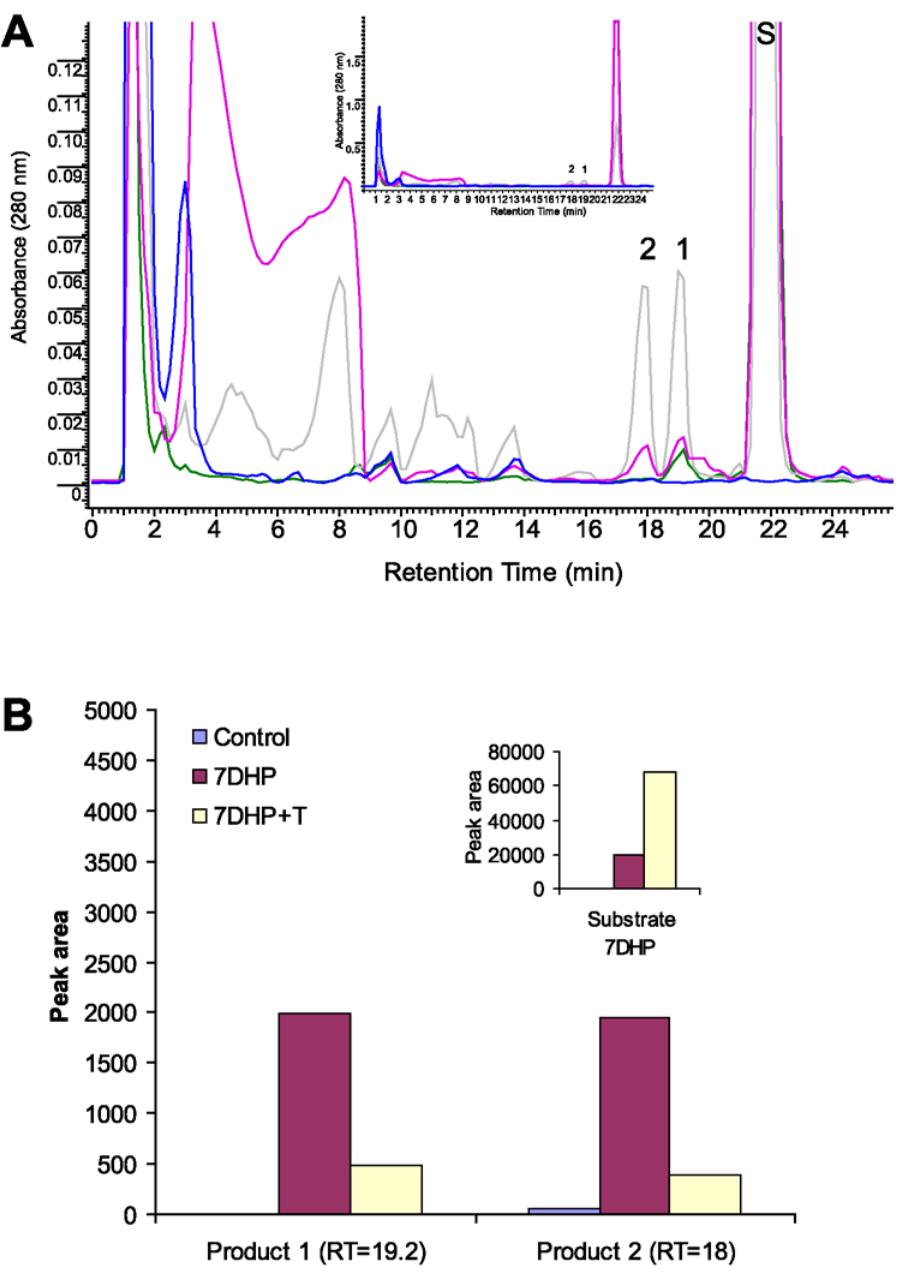
Figure 7. Trilostane (T) inhibits and modifies 7DHP (S) metabolism by rat adrenal glands. A. Fragments of rat adrenal glands were incubated with 7DHP (0.5 mM) in the absence ( pink ) or presence ( gray ) of trilostane (0.1 mM) and samples analyzed by RP-HPLC. Boiled adrenal fragments ( green ) or incubations without the substrate ( blue ) were used as negative controls. B. The relative concentrations of the identified products affected by trilostane (T). The insert shows inhibition of 7DHP consumption by trilostane. Control marked by blue represents or incubations without the substrate.